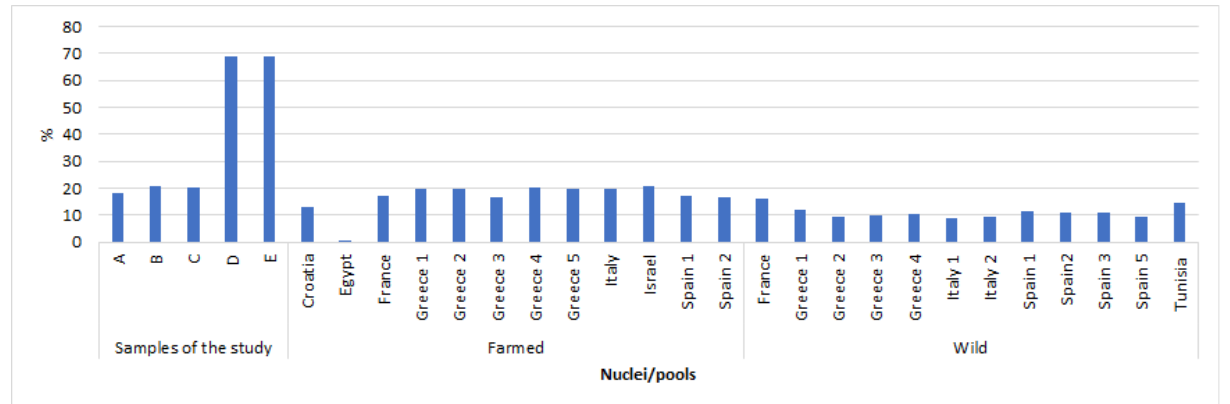
Figure 2. Proportion of monomorphic alleles observed in the different Italian gilthead seabream nuclei sequenced in this study and in farmed and wild populations retrieved from Peñaloza et al., 2021 [7]. The control of inbreeding rate is very important when a selection program is imple- mented since inbreeding depression might negatively counterbalance any genetic progress. Estimates of inbreeding depression in fish have consistently shown that consanguineous progeny presents lower viability, less growth, lower reproductive performance, and less resistance to infections [37–40]. Since seabream is a species with high fecundity, nongenetic maternal effects and high mortality at early life stages can rapidly induce a loss of genetic variability if inbreeding is poorly considered in mating schemes [41]. Considering the common origin of the three DNA pools derived from nucleus A, in the subsequent genome-wide comparison analyses we combined these three subpopulations into